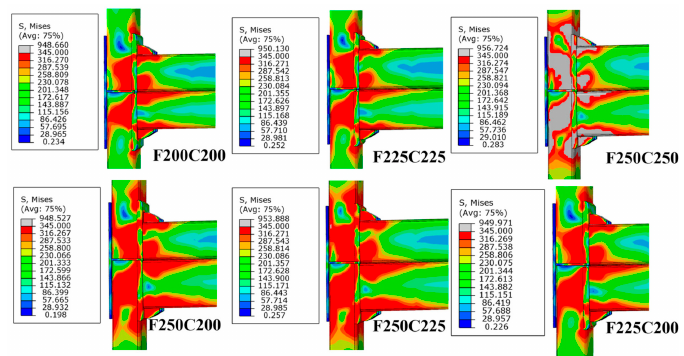
Figure 29. Mises stress distribution of connections with different height.